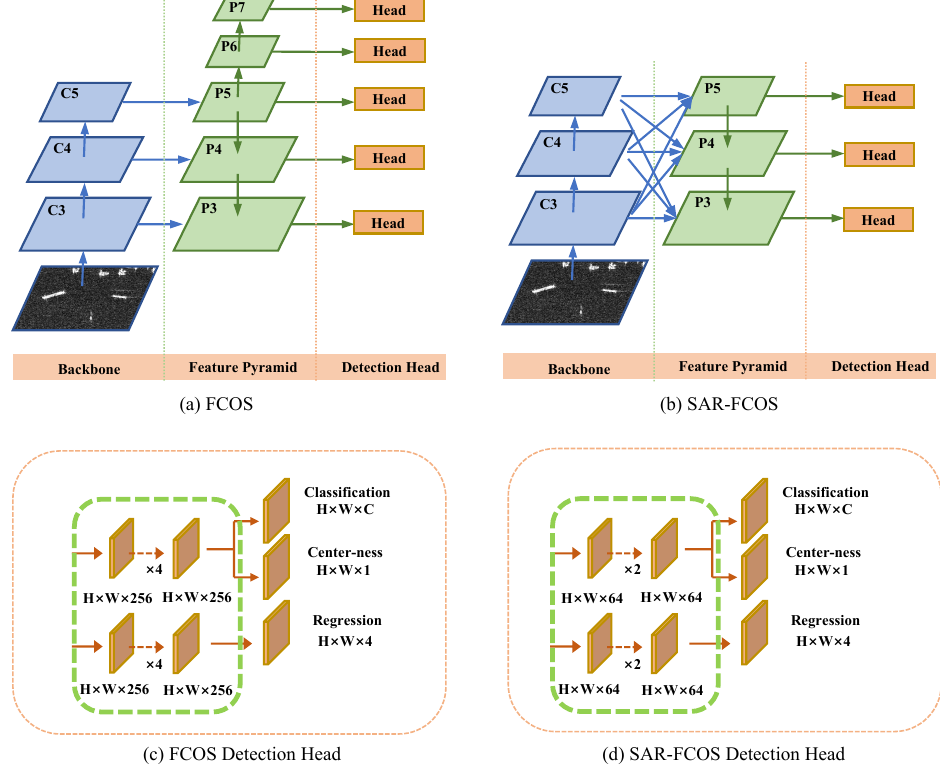
Figure 3. A detailed illustration of the structural difference between the Fully Convolutional One- Stage (FCOS) and